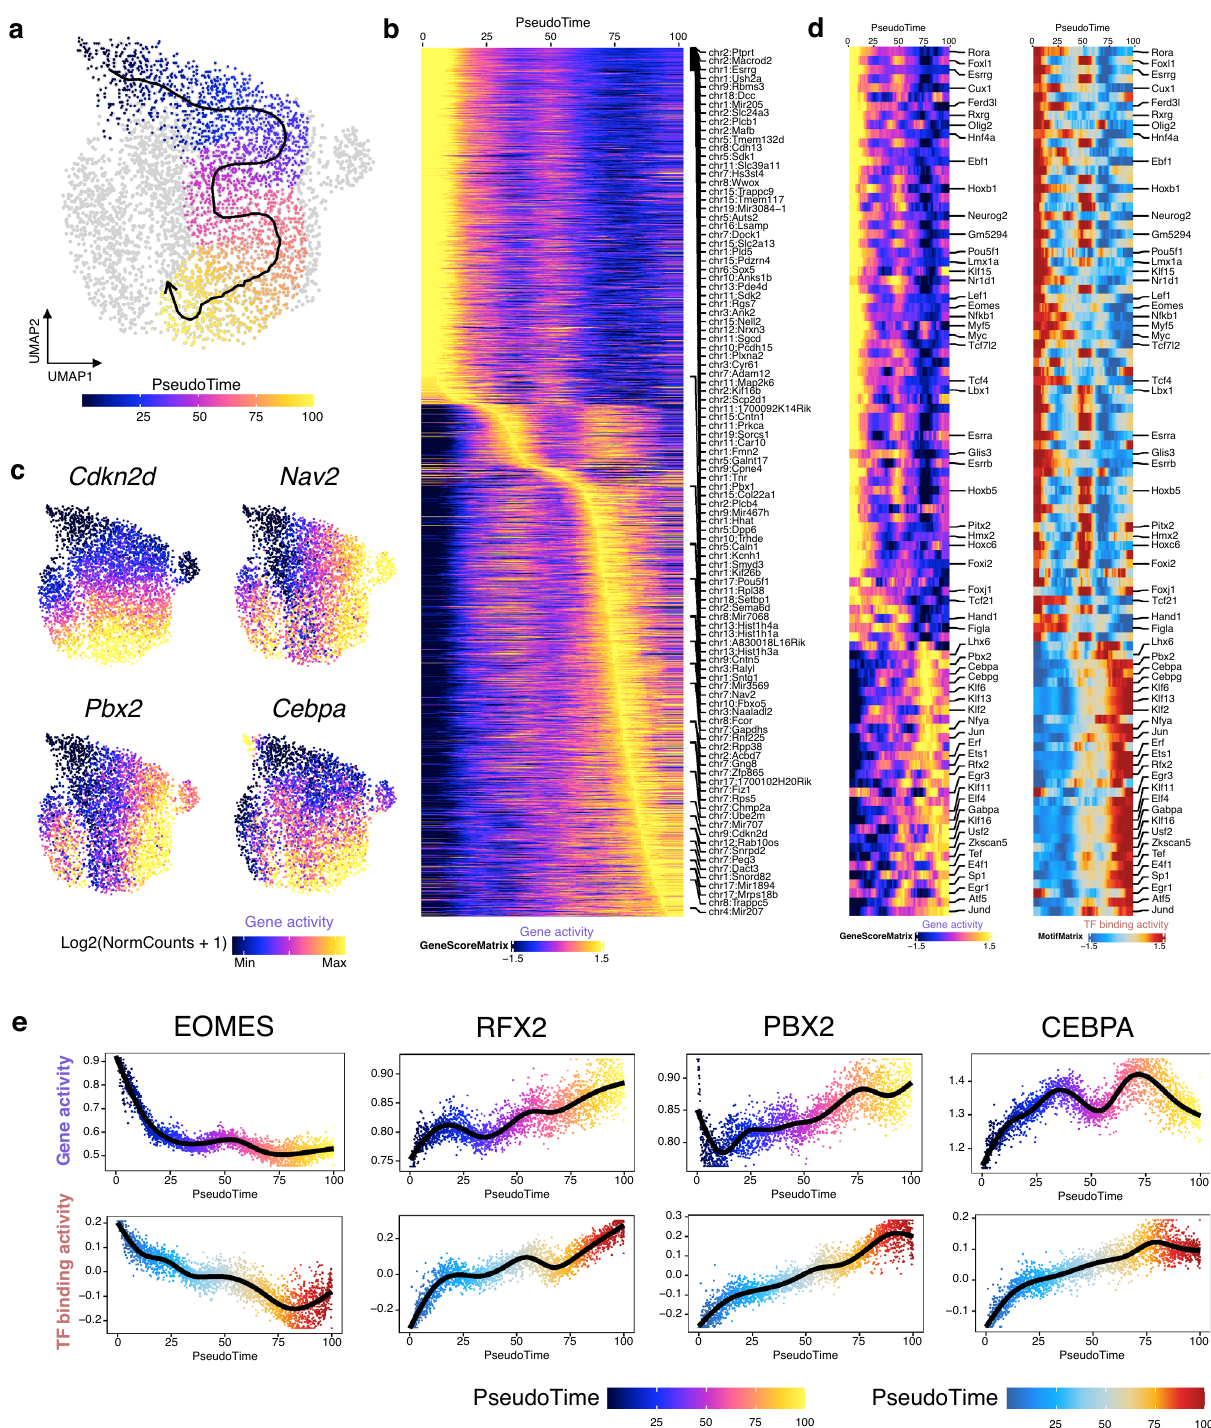
Figure 5. Pseudotime trajectory reveals TF dynamics regulated by retinoic acid (RA). ( a ) scATAC-Seq profiles are ordered by pseudotime, corresponding to the differentiation trajectory induced by RA through Trans.SSC.2. ( b ) Smoothened heatmap depicting genes whose gene score co-varies across pseudotime. ( c ) Gene activity scores of the selected genes shown in UMAP. ( d ) Smoothened heatmap showing dynamic gene score (left) and motif accessibility (right) of indicated TFs along pseudotime for gene-motif pairs of the trajectory. ( e ) Gene activity (top) and motif accessibility (chromVAR TF z-score, bottom) of selected TFs ordered by